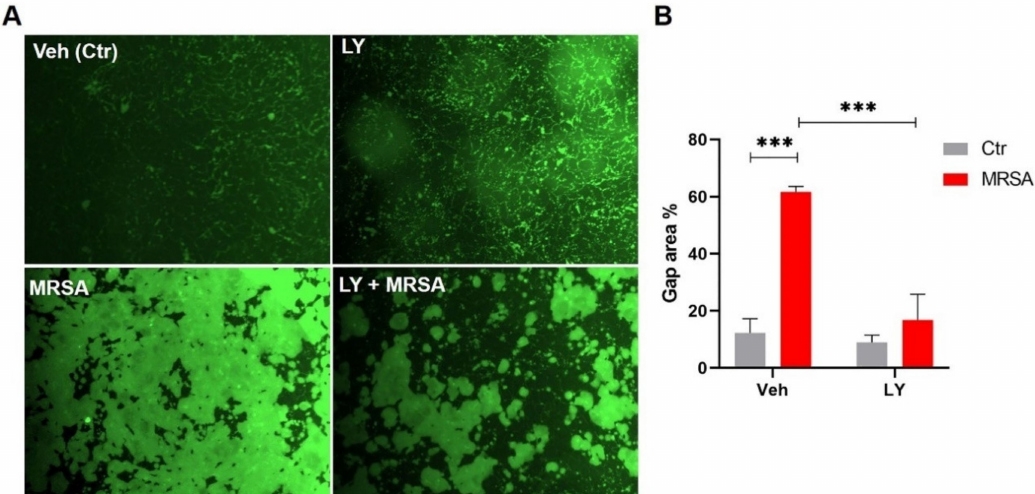
Figure 3. sPLA 2 inhibitor, LY311727, attenuates HK-MRSA-induced lung endothelial intercellular gap formation. HLMVEC monolayers were grown to confluency on biotinylated gelatin coated plates. Cells were pretreated with LY311727 (100 µ M, 1 h) and then challenged with HK-MRSA (2 × 10 8 CFU/mL) for 8 h. FITC-avidin was added to media and allowed to permeate cells to reach biotin substrate at site of paracellular gaps (indicated by green fluorescence). Images were taken using a fluorescence microscope. ( A ): Representative immunofluorescence pictures of interendothelial cellular gaps (10 × magnification). ( B ): Bar graph represents gap area (FITC) quantification. *** p < 0.001. n =